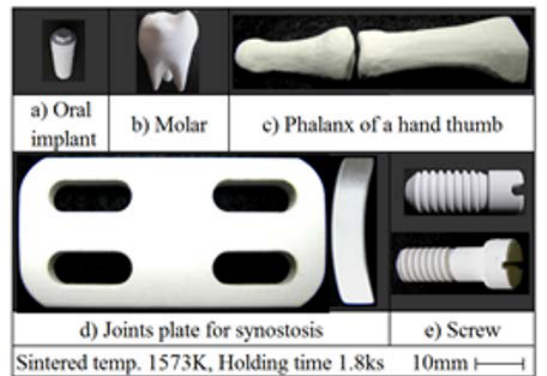
Figure 4. PhotographsofPerovskitecrystalsinTMAsinteredbodies obtained using a polarizing